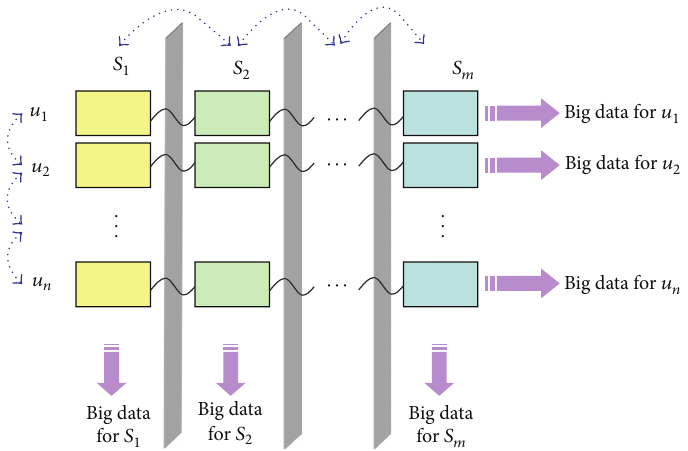
Figure 6: Service-oriented versus user-oriented big